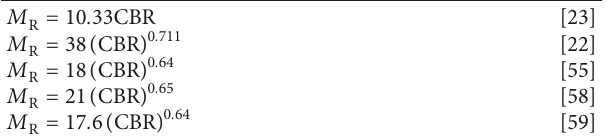
Table 1: Existing models for the estimation of resilient modulus based on CBR